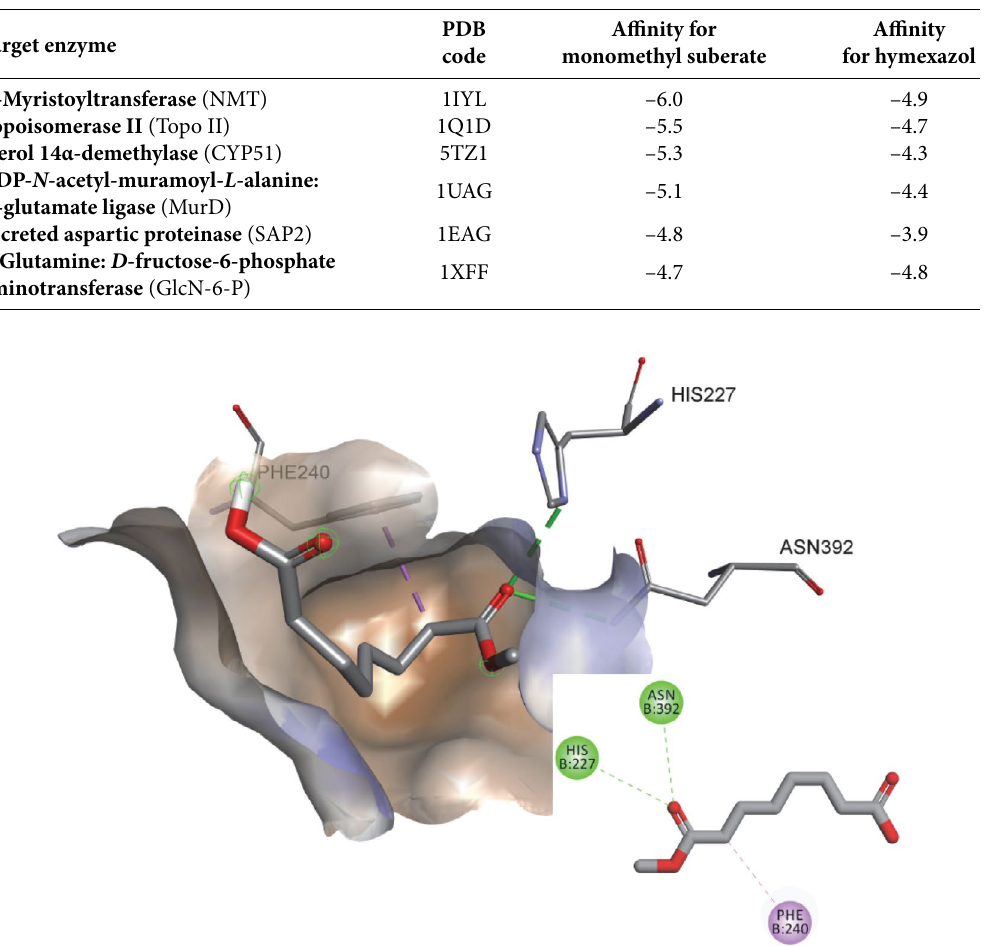
Figure 3. Visual representation (3D and 2D) of the monomethyl suberate showing bonds formation and position in the active site of N -myristoyl- transferase (NMT) of Candida albicans.